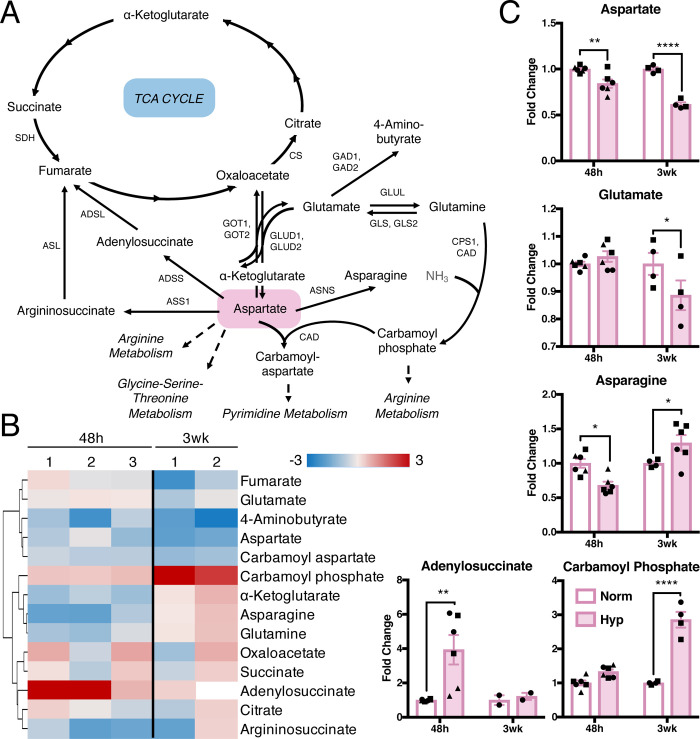
Aspartate and its metabolites are decreased in hypoxia.(A) Metabolites and enzymes in aspartate metabolism. Metabolites in gray not measured or detected. (B) Fold change metabolite abundance over normoxia control for metabolites in pathway A detected in more than one sample. White space indicates metabolite not detected. (C) Significantly altered metabolites from B. Significance by two-way ANOVA. All error bars represent SEM, different symbols represent biological replicates. *, p < 0.05; **, p < 0.01; ****, p < 0.0001. Abbreviations: ADSL, adenylosuccinate lyase; ADSS, adenylosuccinate synthase; ASL, argininosuccinate lyase; ASNS, asparagine synthetase; ASS1, argininosuccinate synthase; CAD, carbamoyl-phosphate synthetase 2, aspartate transcarbamylase, and dihydroorotase; CPS1, carbamoyl phosphate synthetase; CS, citrate synthase; GAD1/2, glutamate decarboxylase 1/2; GLUD1/2, glutamate dehydrogenase 1/2; GLS/GLS2, glutaminase 1/2; GLUL, glutamine synthetase; GOT1/2, aspartate aminotransferase, cytoplasmic/mitochondrial; SDH, succinate dehydrogenase.